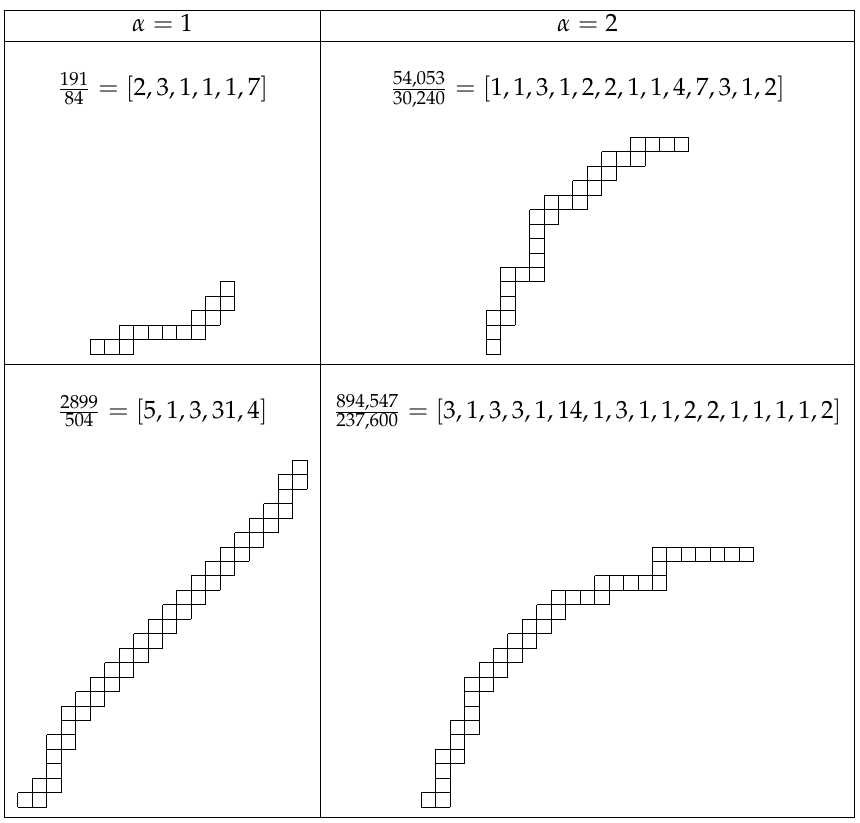
, 2899 , 54,053 , and 894,547 237,600 84 504 30,240